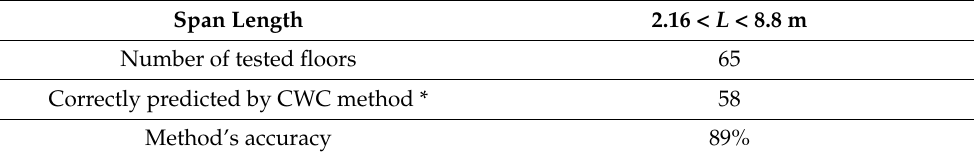
Table 13. The accuracy of CWC [4] (Equation (2) in predicting the vibration performance of lightweight cold-formed steel-timber floors. Span Length 2.16 < L < 8.8 m Number of tested floors 65 Correctly predicted by CWC method * 58 Method’s accuracy